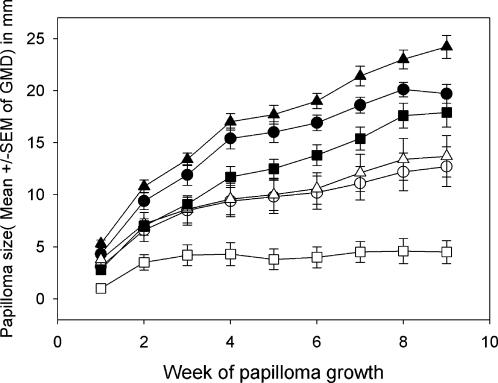
Results of vaccination study.Animals were vaccinated with either wild type E7 (◯,▵,□) or empty vector (•,▴,▪) and were then challenged with each of the CRPV genomes including wild type. Vaccination resulted in a reduction in size of all papillomas. Volumes of wild type, E7/8, E7/14 and E7/18 papillomas were reduced 30–50%, and volumes of E7/22 papillomas were reduced 75% (see Table 1). Figure shows results for wild type (◯,•), E7/18 (▵,▴) and E7/22 (□,▪) papillomas.